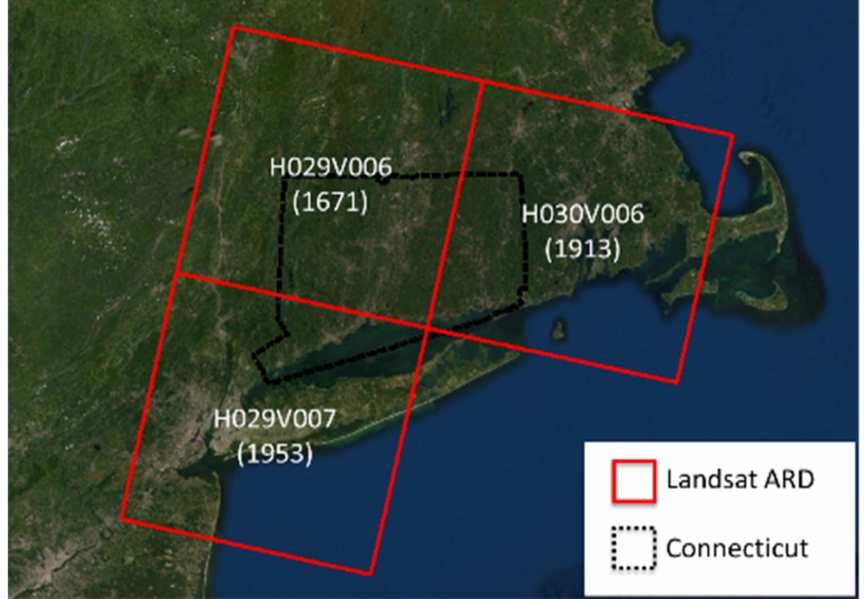
Figure 2. Landsat ARD tiles across Connecticut. The number in the brackets indicates the number of Landsat images in each Landsat ARD tile. ARD: Analysis Ready Data. H: Horizontal. V: